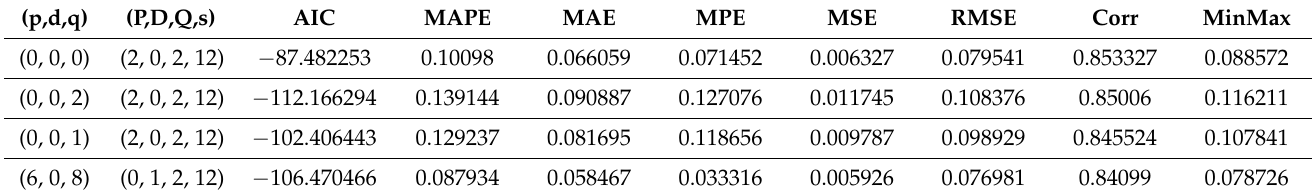
Table 3. Experimental results of SARIMA models with p-values less than